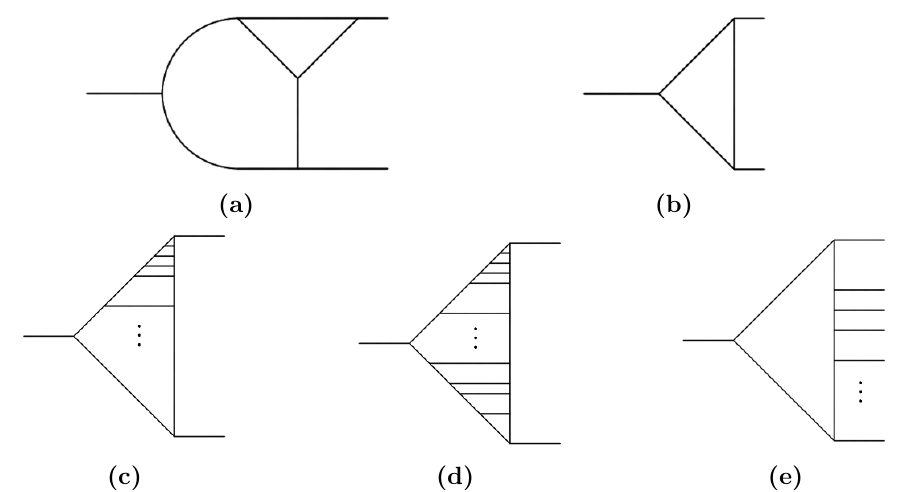
Figure 4. Set of vanishing (sub)diagrams due to particle number conservation. In (e) the number of horizontal lines on the right side is required to be even.